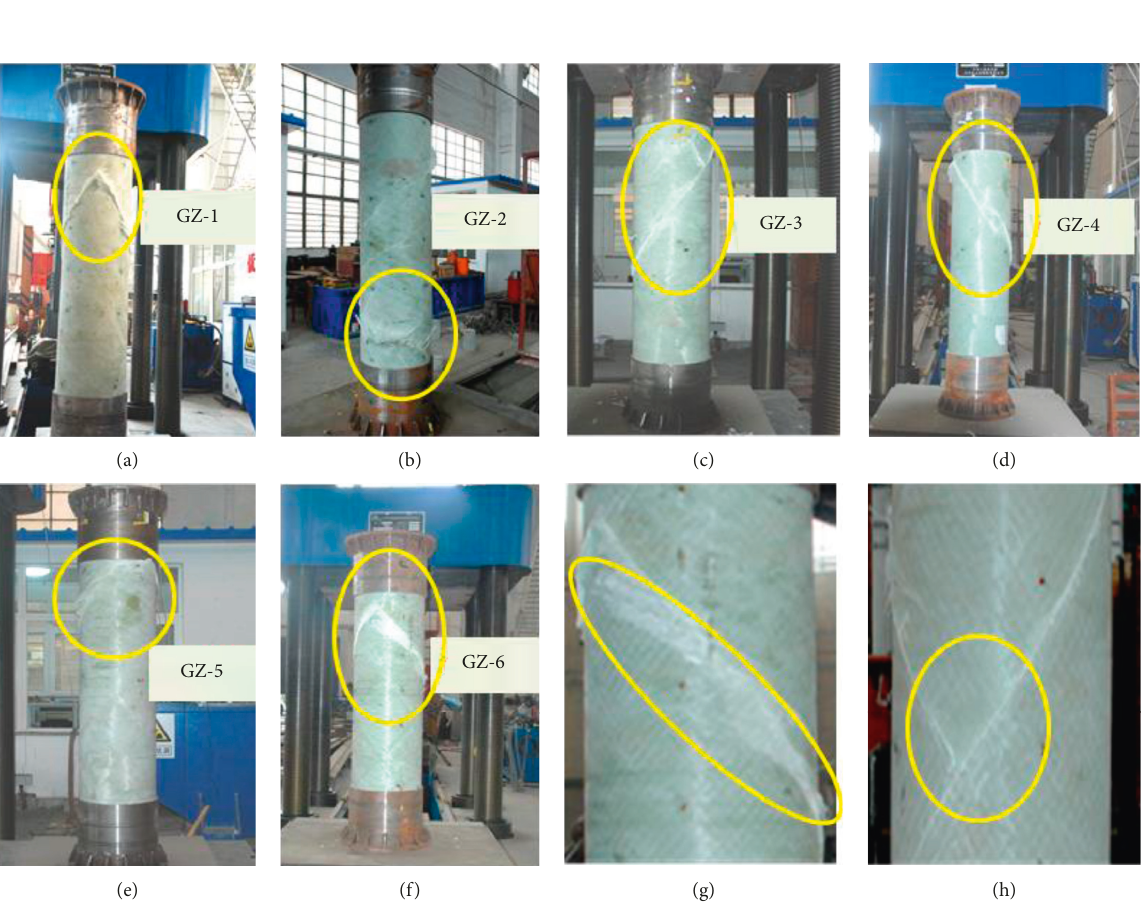
Figure 3: Typical shear failure